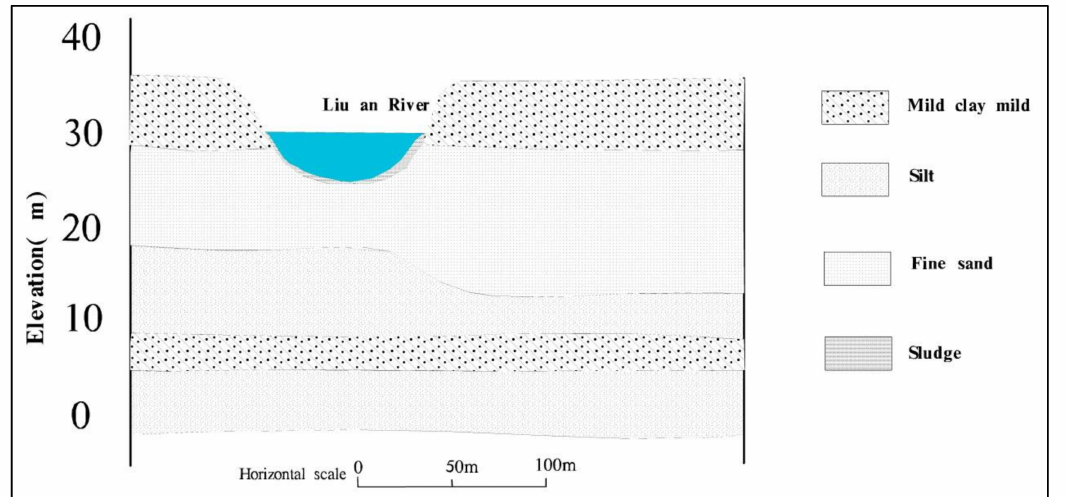
Figure 5. Hydrogeological section of the Liuan River water